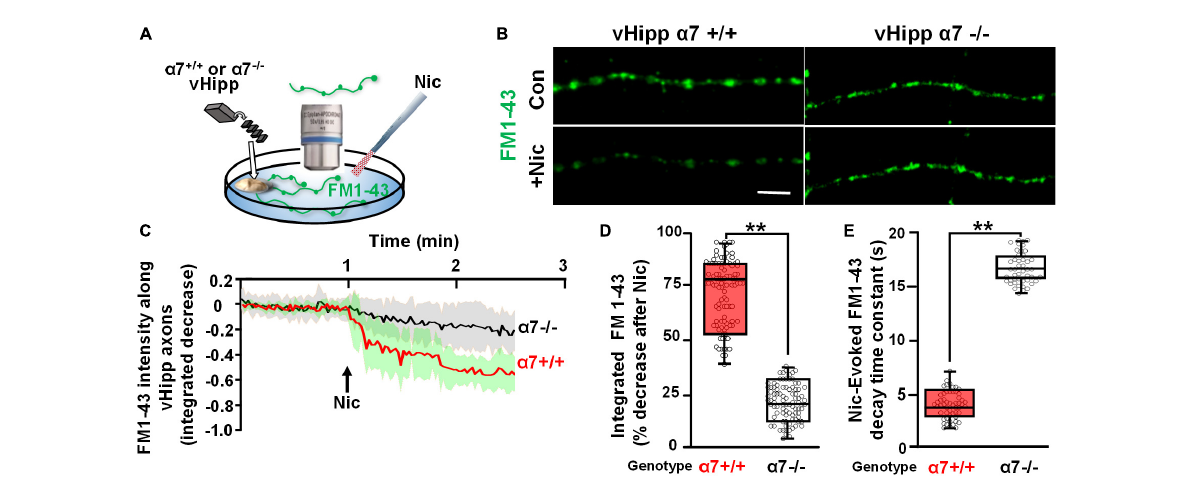
FIGURE1 α 7* nAChRs are required for nicotine-induced FM1-43 de-staining along ventral hippocampal axons. (A) Schematic representation of the experimental configuration. Individual WT ( α 7+/+) or α 7 knock out ( α 7–/–) mice were used for each plating of ventral hippocampal (vHipp) microexplants. These microexplants, prepared as previously described (Zhong et al., 2015) and subsequently thinned by maintenance in minimal media for an additional 24 h, are represented in the schematic as a tissue-colored oblong volume. The axons that grow out of the microexplant (within the same coverslip) are represented by curving lines (here in green to indicate expression of FM1-43). FM1-43 loading is performed as described in “Materials and methods.” The spatial and temporal dynamics of nicotine-induced release was assayed by high resolution imaging (spinning disk confocal; see details in “Materials and methods”) of FM1-43 de-staining along individual vHipp axons. All drug application was by local micro perfusion as represented in the schematic by a single application pipette. (B) Representative micrographs of α 7+/+ ( B , left) and α 7–/– ( B , right) vHipp axons (labeled with FM1-43, green) before ( B , top) and after ( B , bottom) nicotine (1 µ M, 1 min) application are shown. Scale bar, 10 µ m. (C) Averaged traces of the FM1-43 fluorescence time course assayed along α 7+/+ and α 7–/– vHipp axons are shown before and after nicotine application. For the α 7+/+ we have plotted the averaged change in fluorescence of 40 independent axon segments of ∼ 15 µ m each, from 5 separate experiments (red line); the standard deviation is shown in green shading. We will use the following notation in the subsequent figure legends: n = #axon segment, ## separate experiments. Averaged traces from α 7–/– ( n = 40, 4) before and after nicotine application (black line; SD as gray shaded area). Images collected every 1.5 s for 5 min. FM1-43 fluorescence intensity was calculated and quantified as a normalized integrated intensity at individual 1- µ m spots at each time point to yield these representative plots. See Table 1 for sample and statistical details. (D) Box plots of the pooled data by condition tested. Box plots are overlaid with all of the data points shown here as a scatter plot. Data for α 7+/+ ( n = 100 axon segments; 5 separate experiments) and α 7–/– ( n = 92 axon segments, 4 separate experiments). The efficacy of nicotine induced neurotransmitter release along vHipp axons was assayed as the percent decrease of overall FM1-43 fluorescence intensity after nicotine application. The extent of nicotine-induced FM1-43 de-staining was significantly lower in vHipp axons from α 7–/– mice, compared with the α 7+/+ controls (** p < 0.001). All data were first tested for distribution normality by the test(s) listed in Table 1 prior to statistical analysis. See Table 1 for all sample and statistical details. (E) Box plots of pooled data by condition tested with overlaid scatter plots of all individual data points) from both α 7+/+ and α 7–/– vHipp axons. The decay time constant ( τ ), a dynamic indicator of the rate